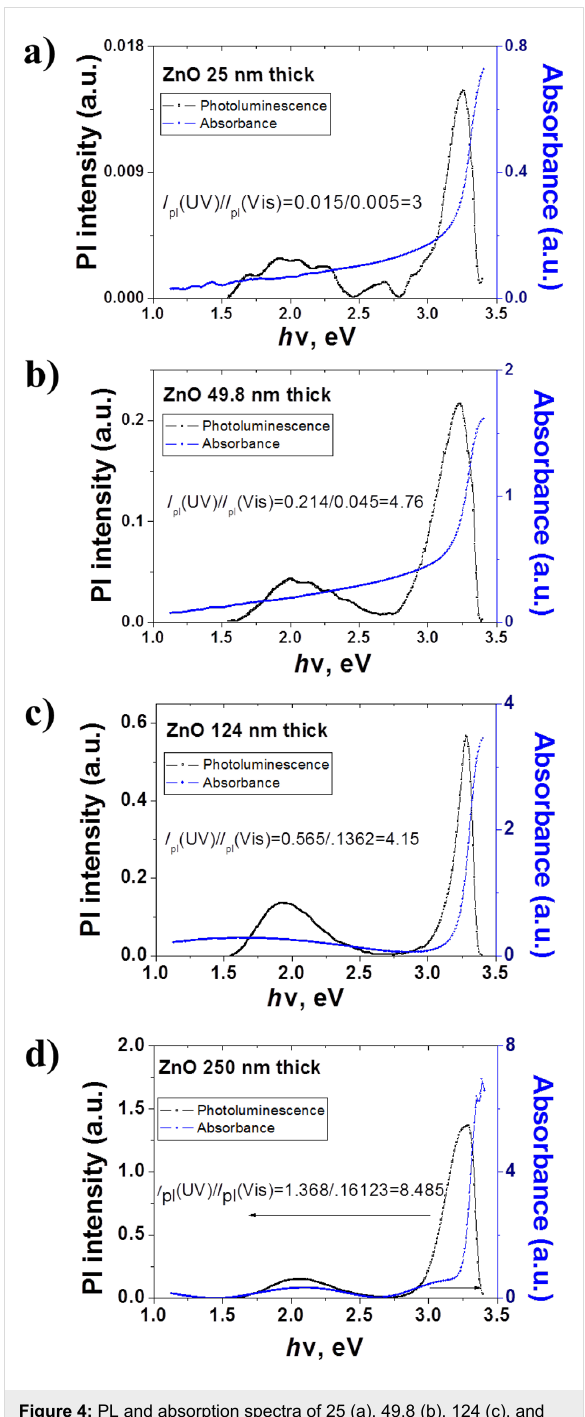
Figure 4: PL and absorption spectra of 25 (a), 49.8 (b), 124 (c), and 250 nm (d) thick ZnO ALD films.